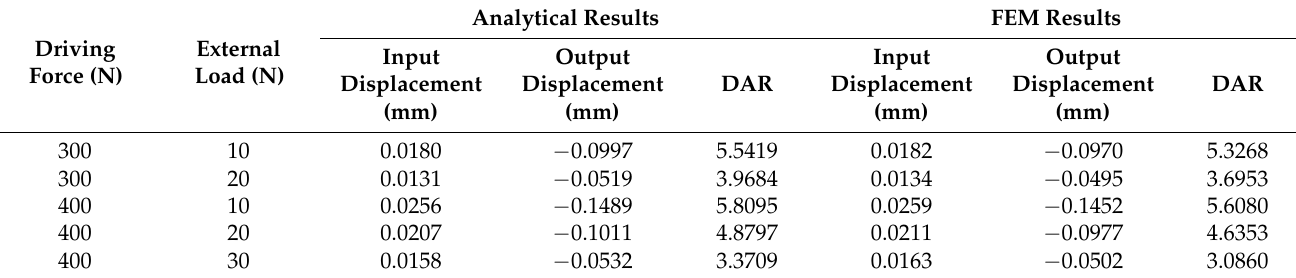
Table 6. The analysis results of the vertical micro/nano-positioning mechanism.